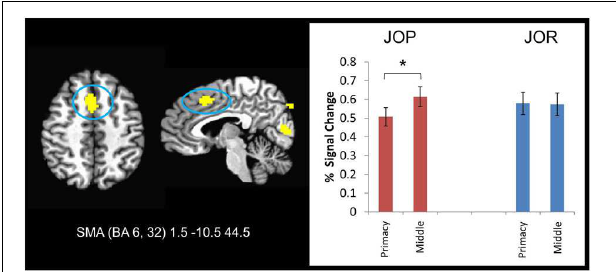
FIGURE 6 | A frontal lobe region showing an interaction between task and serial position on activation during the retrieval period of JOR and JOP. During the JOP task, individuals showed a higher level of activation during middle item trials than during the primacy item trials. No such difference emerged during the JOP task. ∗ denotes significance at p < 0 .